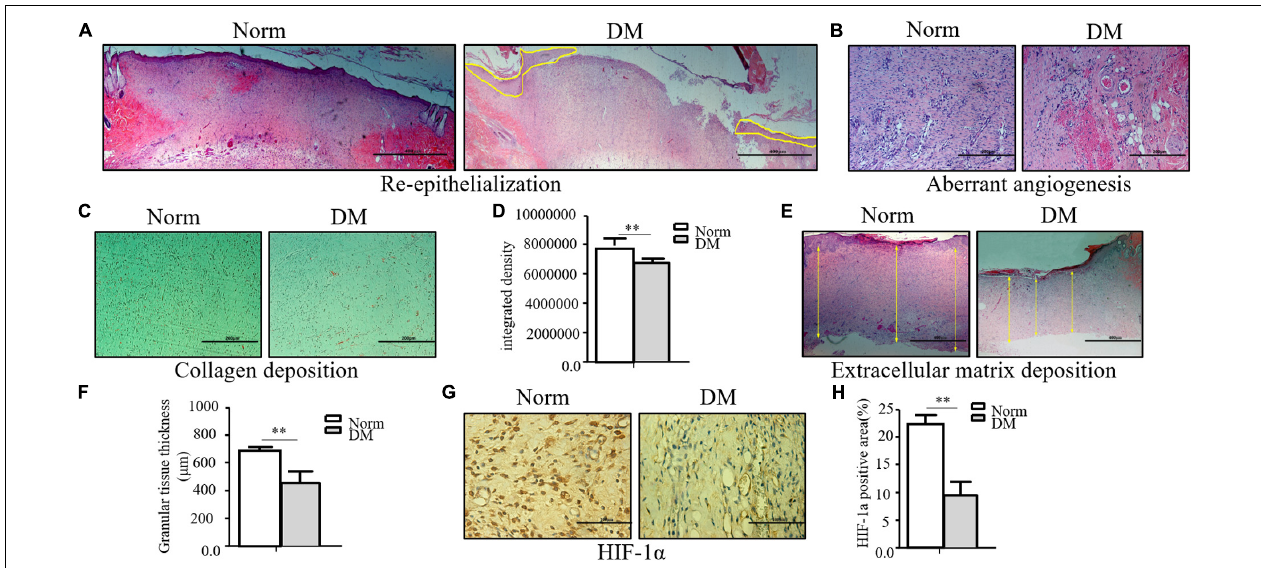
FIGURE 1 | The wound healing process was significantly impaired in the diabetic state. (A–F) The diabetic wound manifests characteristics of impaired re-epithelialization (A) , aberrant angiogenesis (B) , and impaired collagen deposition (C,D) examined by Masson trichrome staining. Decreased extracellular matrix deposition (E,F) shown by H&E observation. (G,H) HIF-1 α significantly decreased in diabetic wound. HIF-1 α of normal and diabetic wounds was examined through immunohistochemistry. The collagen deposition density, extracellular matrix thickness, and HIF-1 α positive area were calculated by ImageJ. Data are shown as mean ± SD. ** p < 0.01, n =